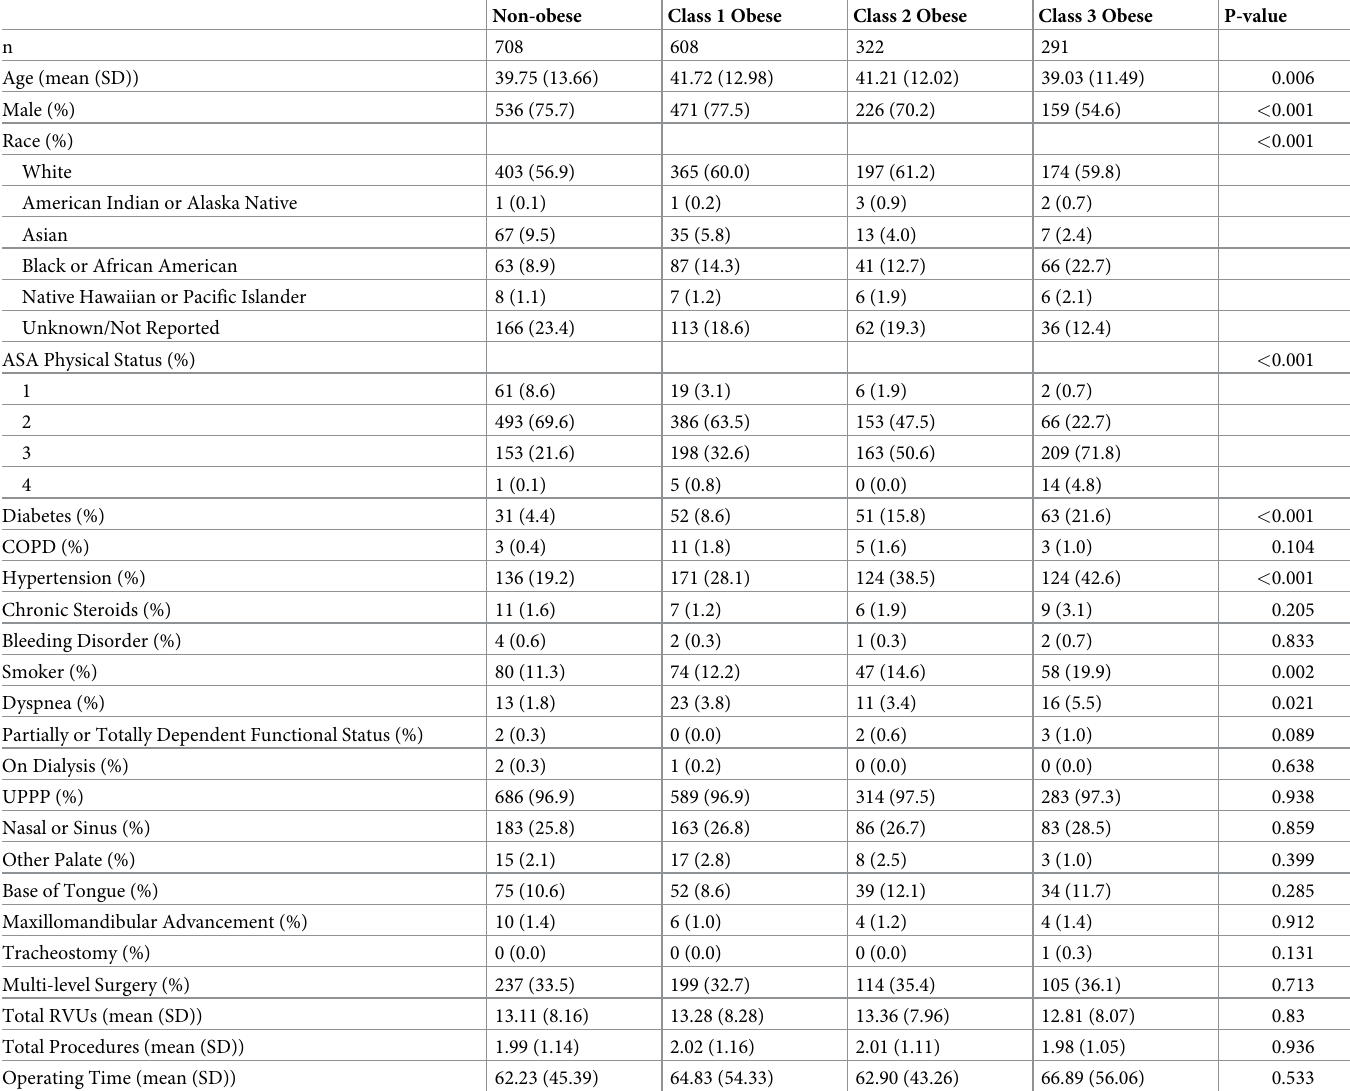
Table 1. Baseline characteristics of the study